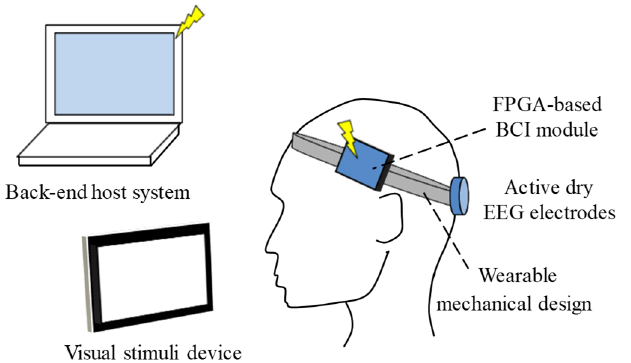
Figure 1. Basic scheme of proposed wearable headset with steady-state visually evoked potential (SSVEP)-based brain–computer interface (BCI).